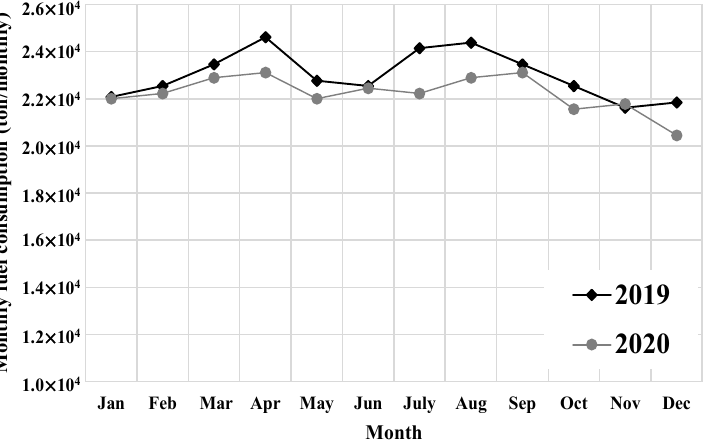
Figure 5. Spatial analysis of annual fuel consumption in BP in 2019 ( Left ) and 2020 ( Right ).